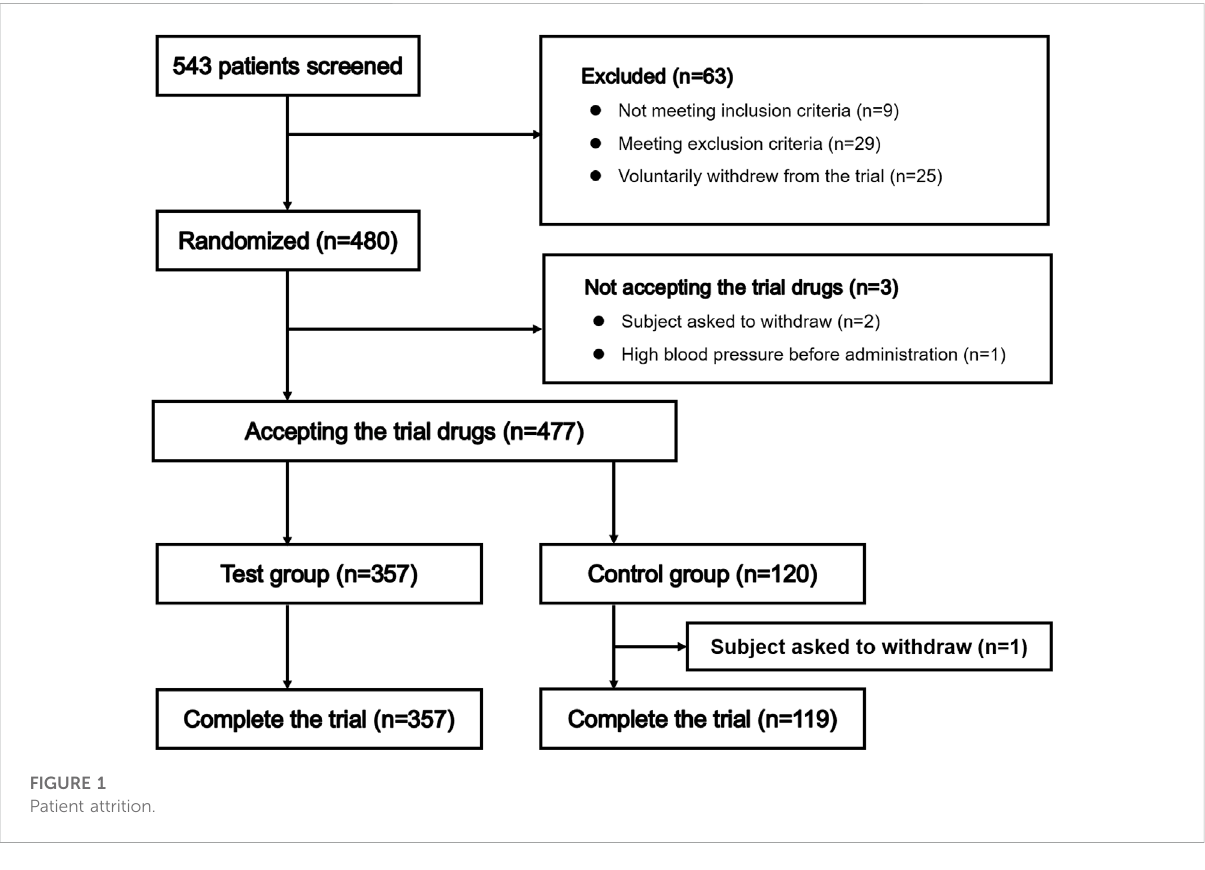
FIGURE 1 Patient attrition.